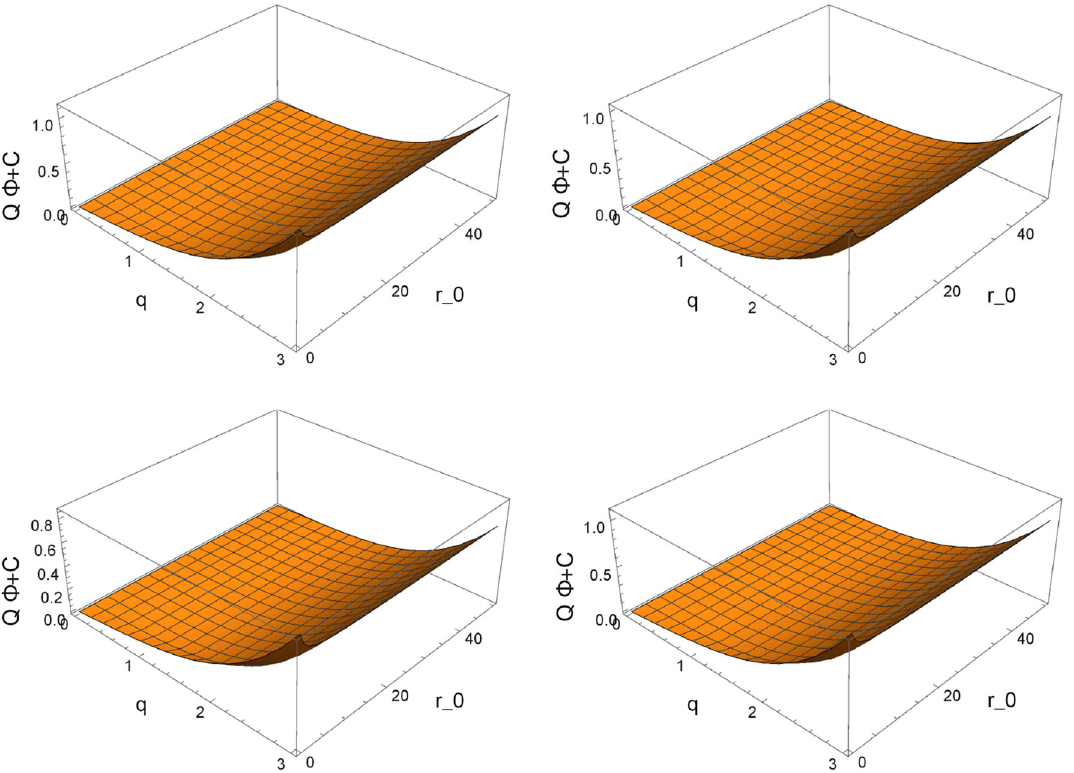
Fig. 2 Plots of Q (cid:16) + C 1 for different β,γ choices. Here we set κ = 1 and g = 1 for all polts, while from top left panel to top right panel then down left panel to down right panel, we set (β,γ) equal to ( 0 . 1 , 0 . 1 ),( 0 . 5 , 0 . 5 ),( 1 , 1 ), and ( 0 . 1 , 1 ) respectively. All panels show that Q (cid:16) + C